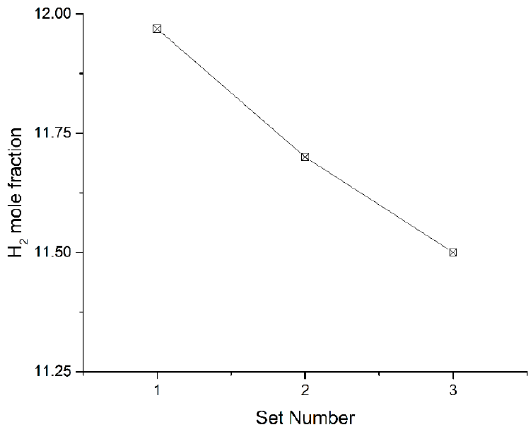
Figure11. H 2 molefractioninproductsforchemicalreformerswithdi ff Figure 11. H 2 mole fraction in products for chemical reformers with different numbers of reforming Figure 11. H 2 mole fraction in products for chemical reformers with different numbers of reforming units. Figure 11. H 2 mole fraction in products for chemical reformers with different numbers of reforming units. units.